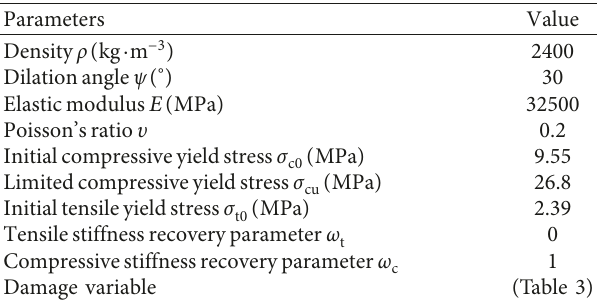
Table 6: Material properties of concrete. Table 7: Stress and damage factor versus plastic strain of